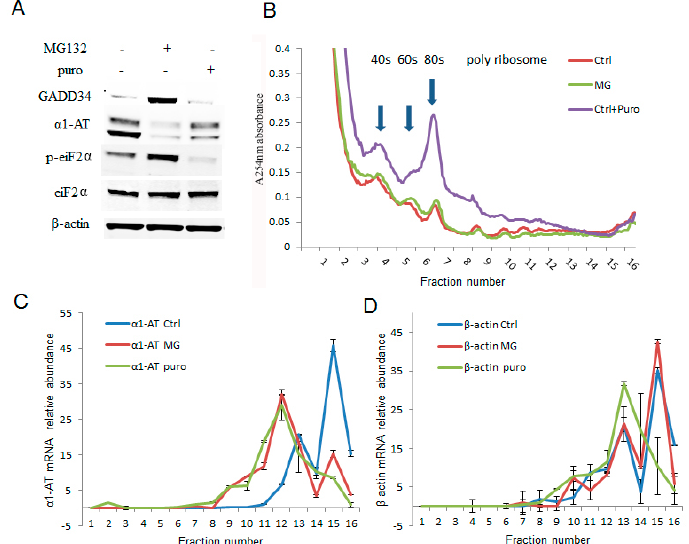
Figure 4. Proteasome inhibitor MG132 inhibited α 1AT mRNA translation. ( A ) C3A cells were treated with MG132 (10 µm) for 4 h and puromycin (2 µg/mL) for 30 min. The steady state level of GADD34, α 1AT, p-eIF2 α , eIF2 α and β -actin were detected by western blotting using specific antibodies. ( B ) C3A cells lysates from ( A ) were fractionated on 10–50% sucrose gradients, 40S, 60S and 80S ribosomal subunits (fraction 3–7) as well as polysomes (fraction 8–16) were measured by detecting absorbance at 254 nm. ( C , D ) mRNA of α 1AT ( C ) and β -actin ( D ) in each gradient fraction were measured by quantitative real-time PCR. mRNA level was calculated by spiked internal control and plotted as a percentage of the total mRNA levels in that sample. Data represent the mean of three independent experiments ± SD.